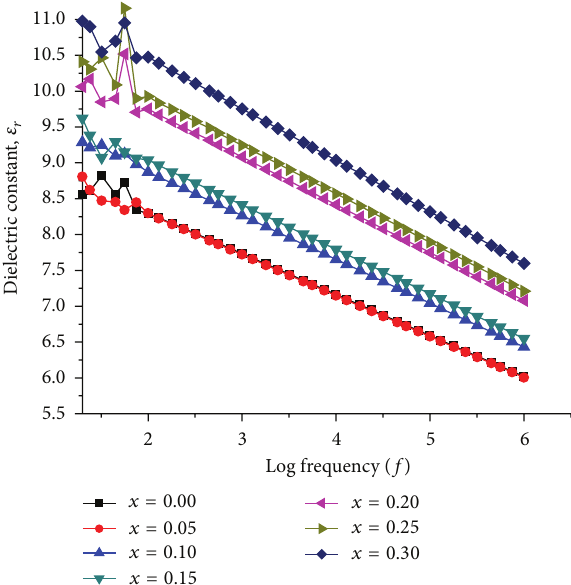
Figure 6: Variation of dielectric constant of Ca 𝑥 Zn (1−𝑥) Al 2 O 4 with applied frequency.